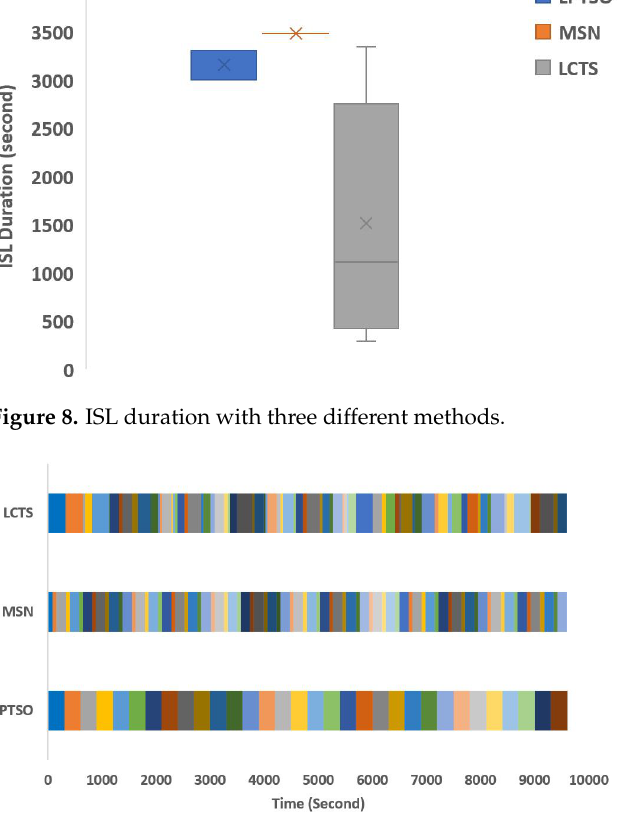
Figure 9. Topology switches with three different methods.